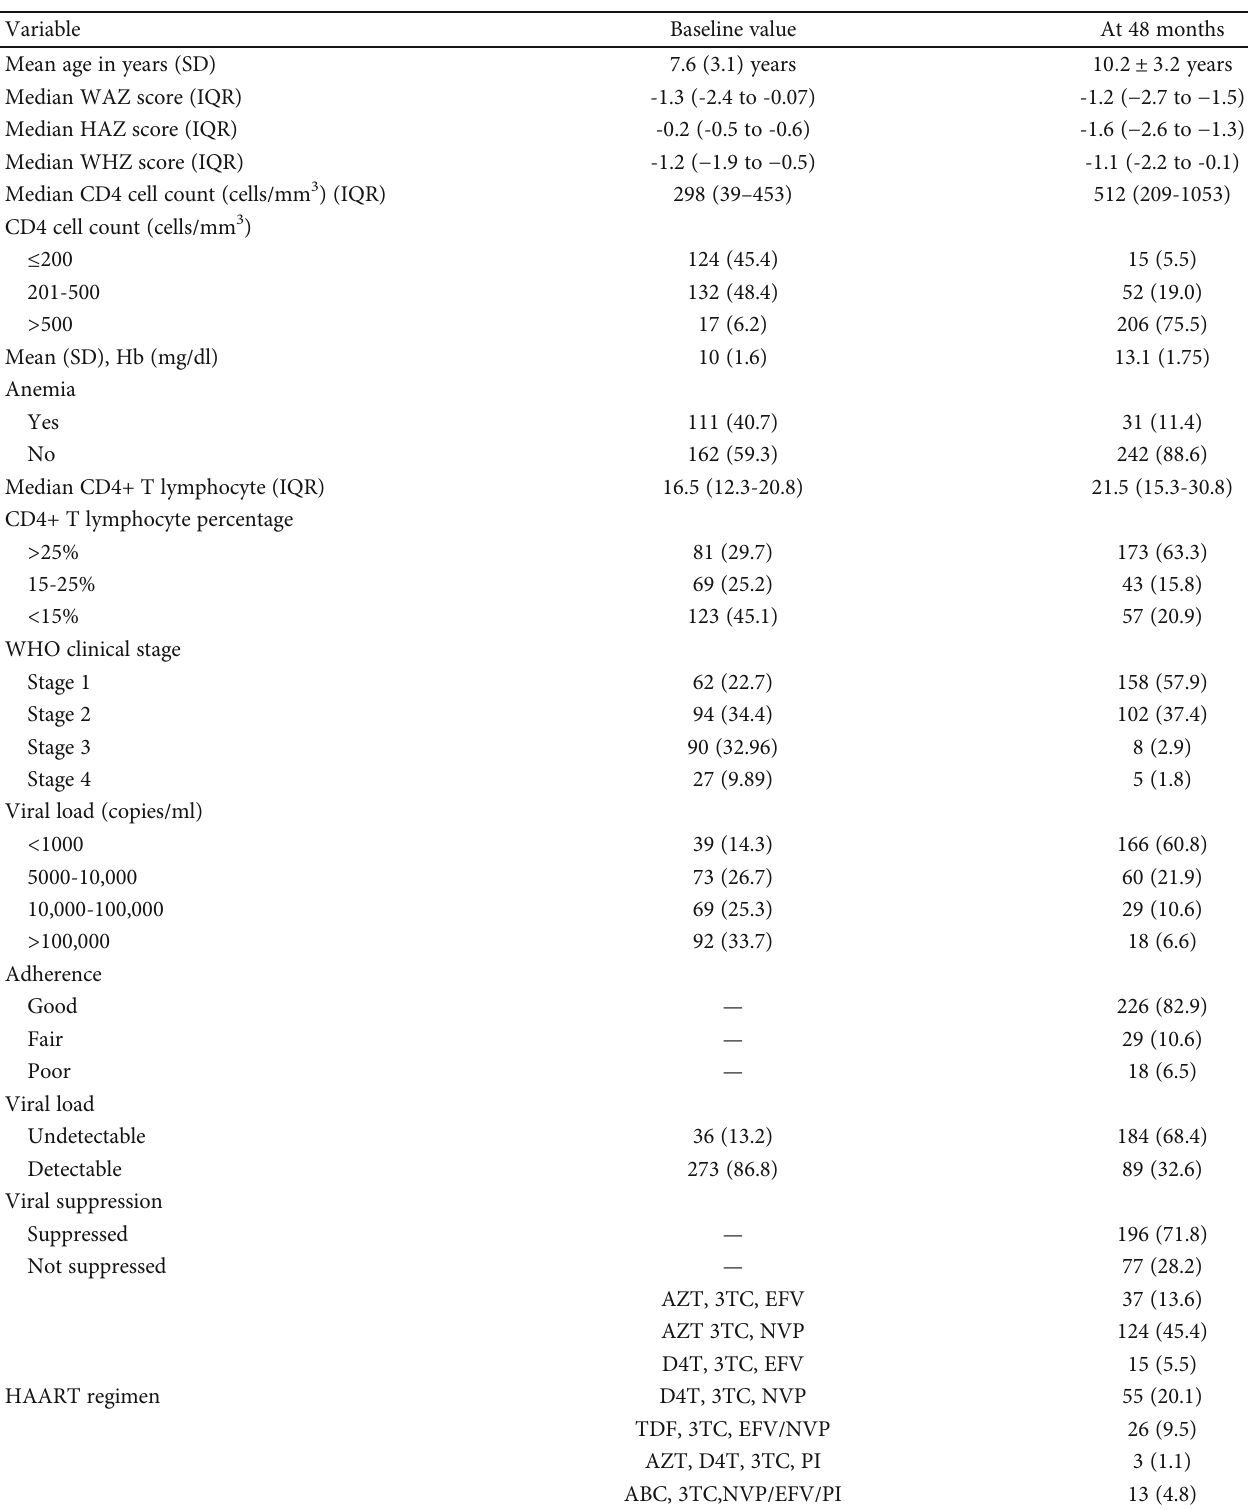
Table 2: Immunological, virological, and clinical characteristics of HIV-infected children at baseline and 48 months ( N = 273